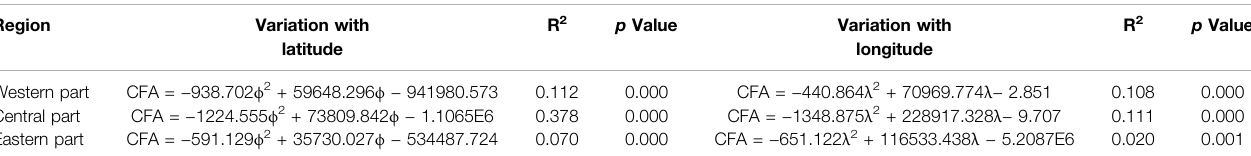
TABLE 2 | The CFA variations against latitude ( ϕ ; ° ) and longitude ( λ ; ° ) in the western, central, and eastern parts of the Gangdise Mountains. Region Variation with R 2 latitude